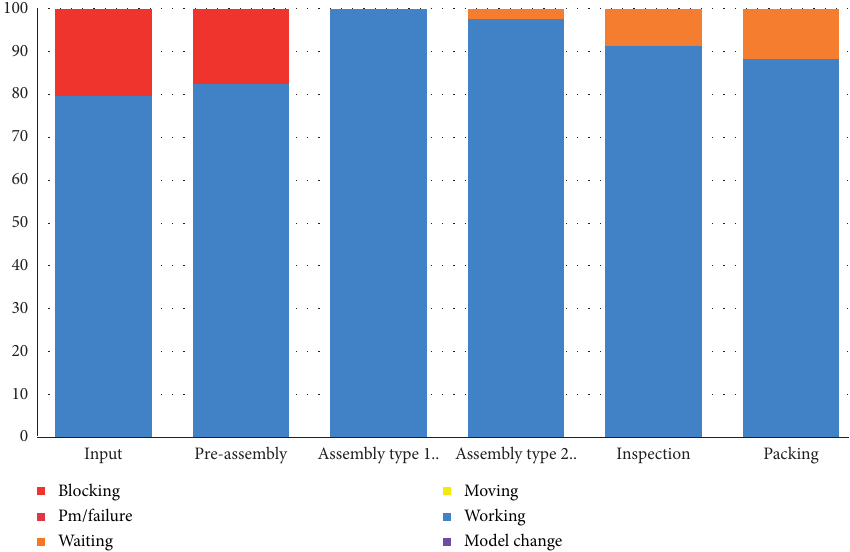
Figure 12: Simulation results of process load for initial measured process time.